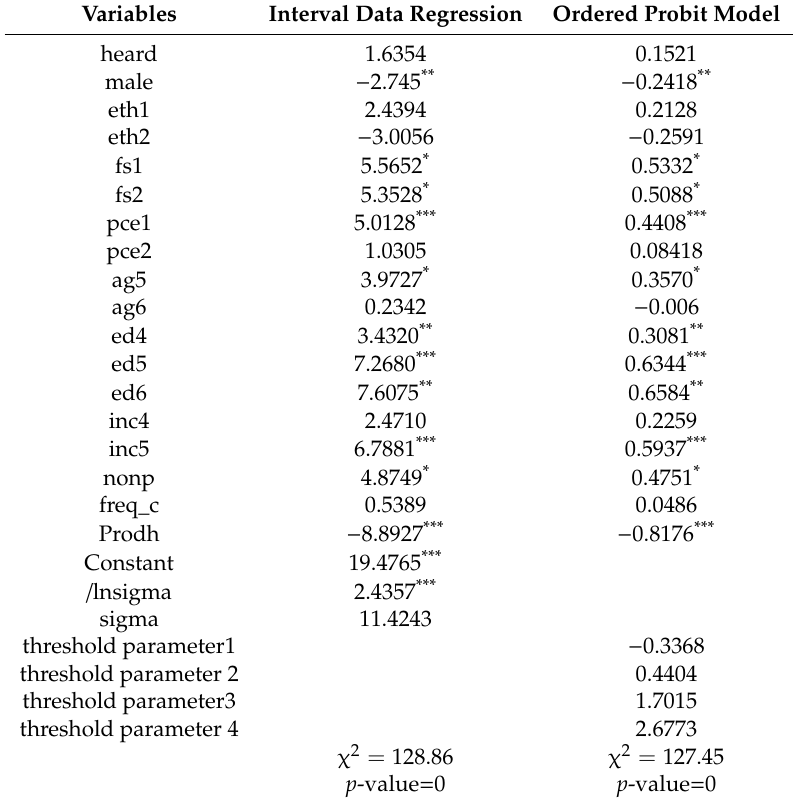
Table 3. Estimation